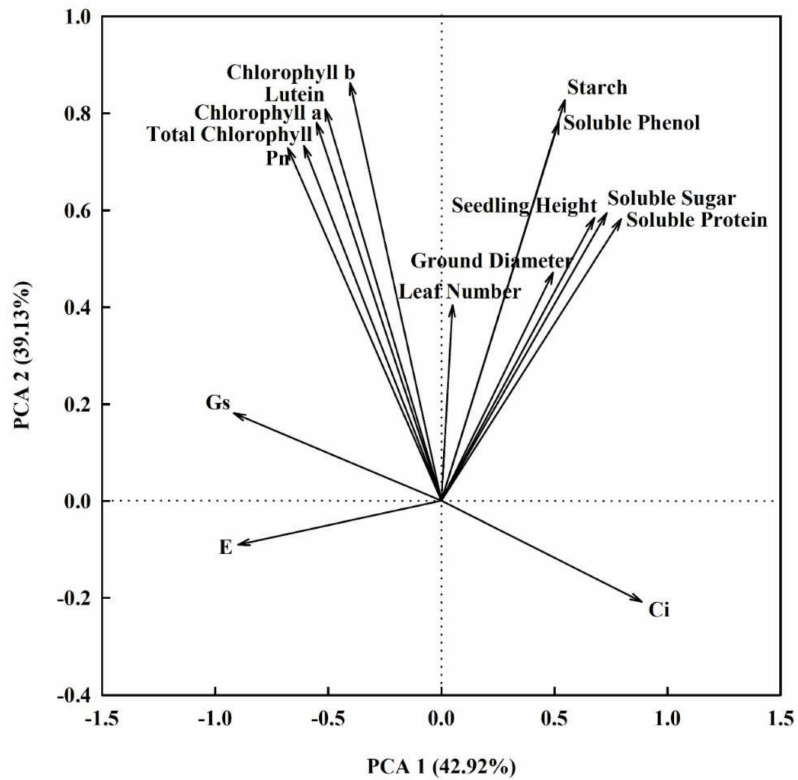
Figure 4. Factor loads of PCA. The soluble sugar, starch, soluble protein, and soluble phenol in the figure represent the total concentration of roots, stems and